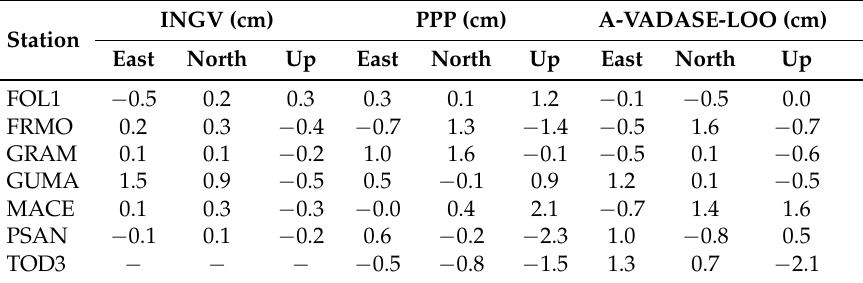
Table 6. Coseismic displacements: 26 October 2016 earthquake.